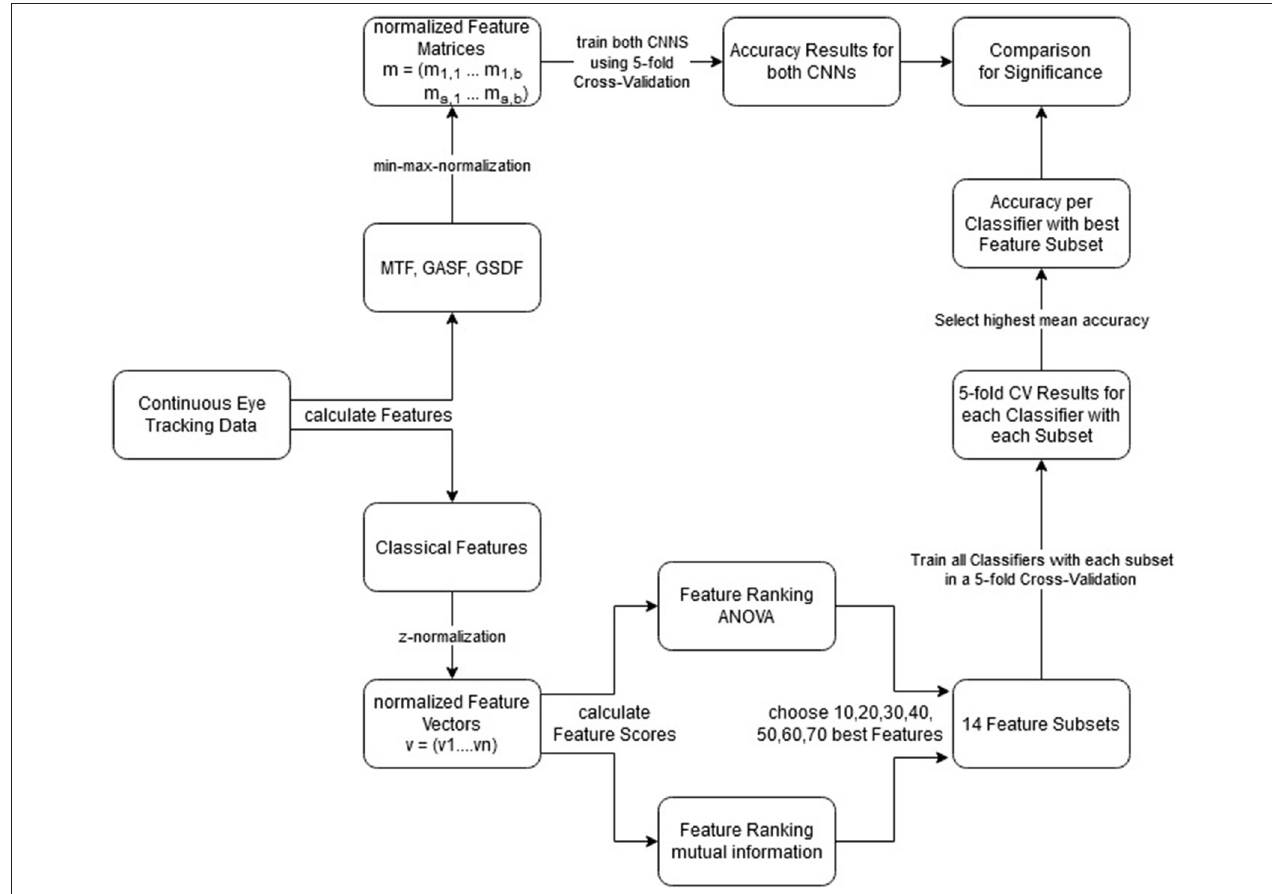
FIGURE 8 | Combined pipelines of the statistical summary and the ITS approach. Explaining step by step what was done to get from the continuous eye tracking data to the performed comparisons. Clockwise, ITS approach; Counter-Clockwise, statistical summary